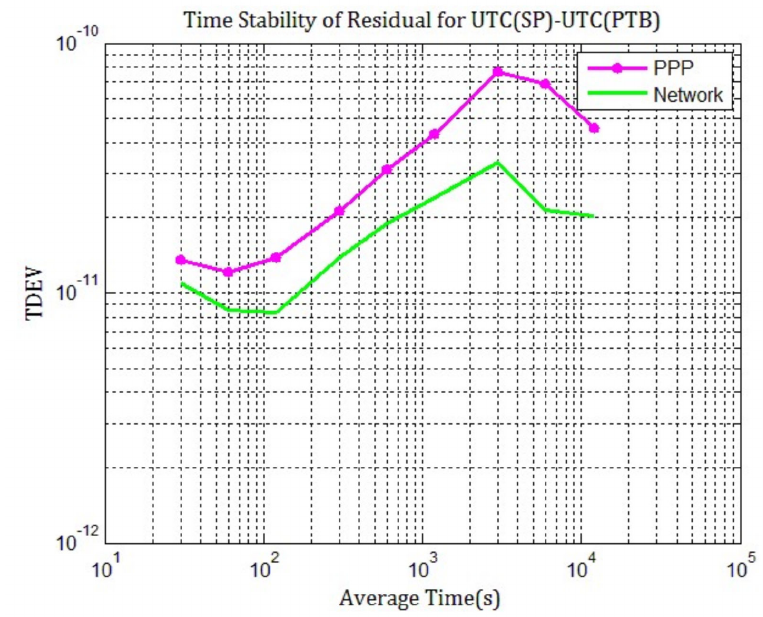
Figure 4. TDEV of the residuals between PPP (purple), network solution (green) and TAIPPP provided by BIPM from MJD 58624 to